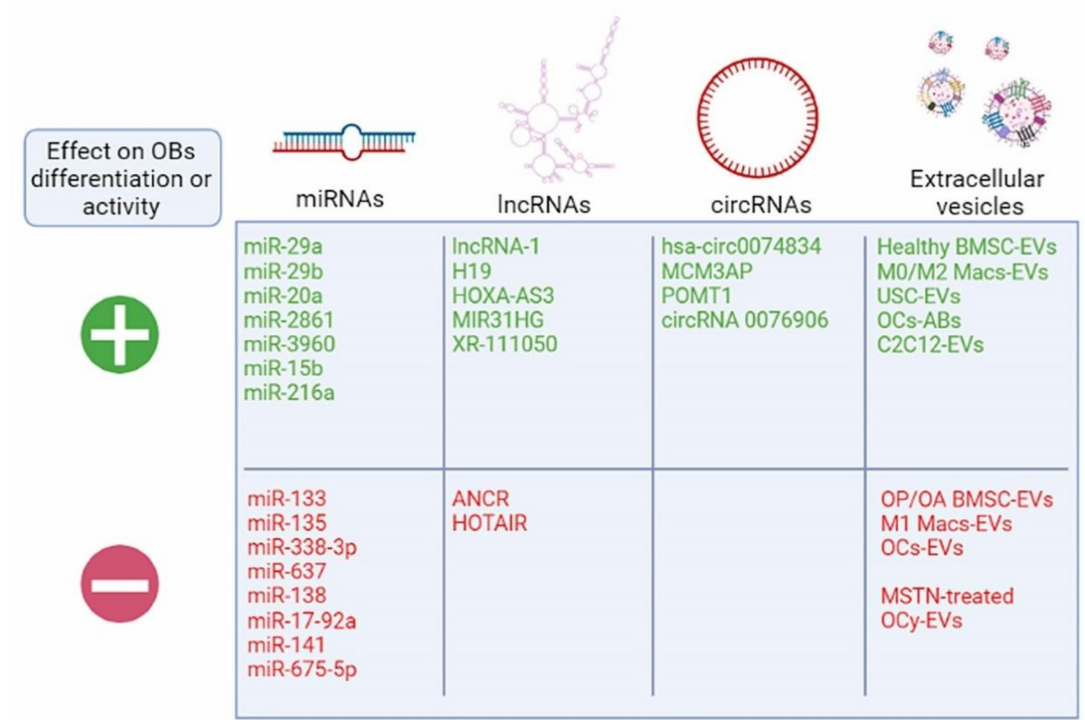
Figure 3. Novel players in osteogenesis. Cartoon listing the non-coding RNAs and extracellular vesicles described in the review. Macs—macrophages; OCs—osteoclasts; OP/OA—osteoporotic/osteoarthritic patients; MSTN—myostatin; OCy—osteocytes. Created with